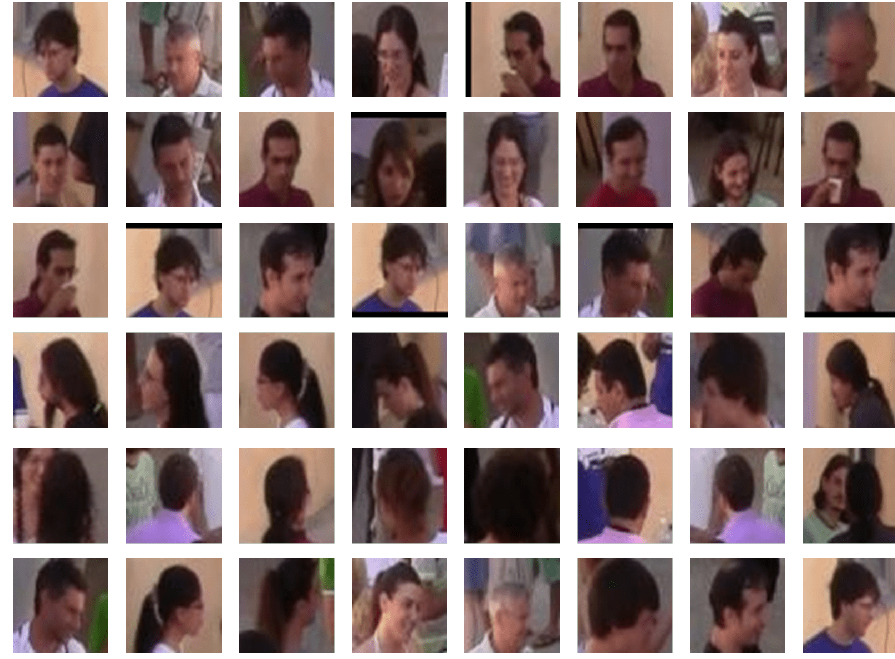
Figure 4. Examples of images from the HOCoffee dataset. It contains six head pose classes, from the first row to the last one (front left, front, front right, left, rear and